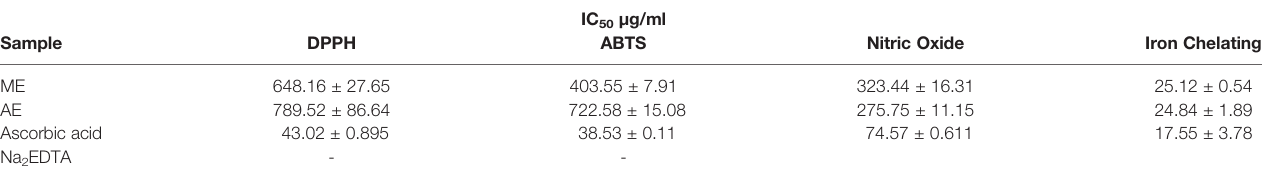
TABLE 2 | IC 50 value of methanolic and aqueous extract of U. indica.